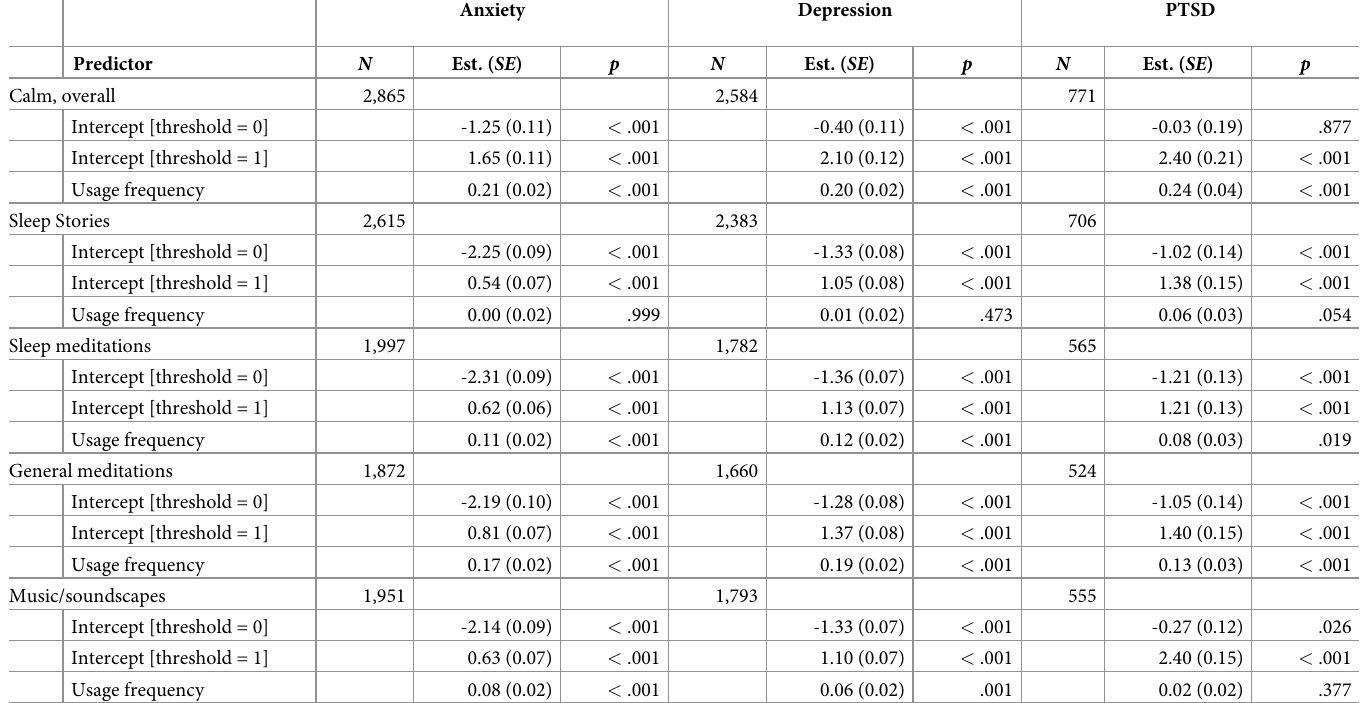
Table 9. Parameter estimates for regressions models of improvements in mental health diagnoses based on frequency of using Calm and its components (i.e., Step